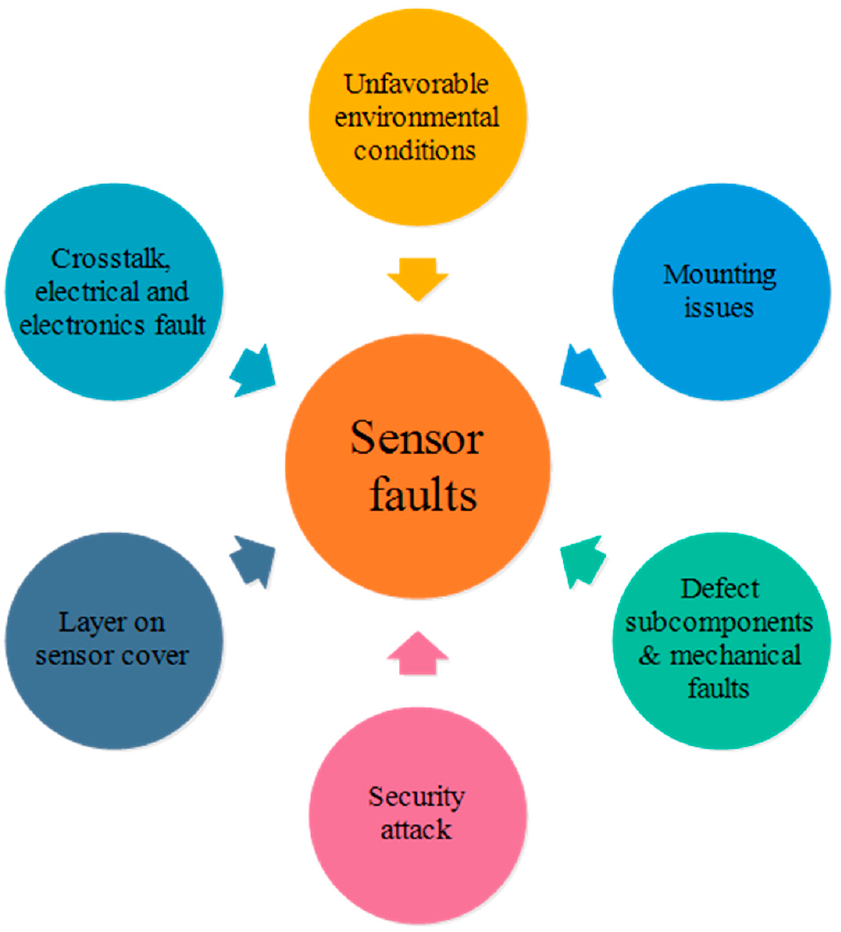
Figure 4. Demonstration of various sensor faults.